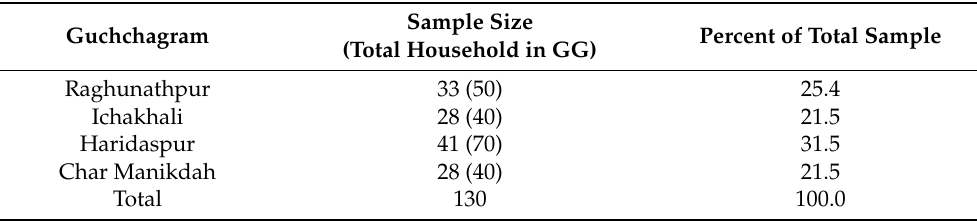
Table 2. Study area and sample size